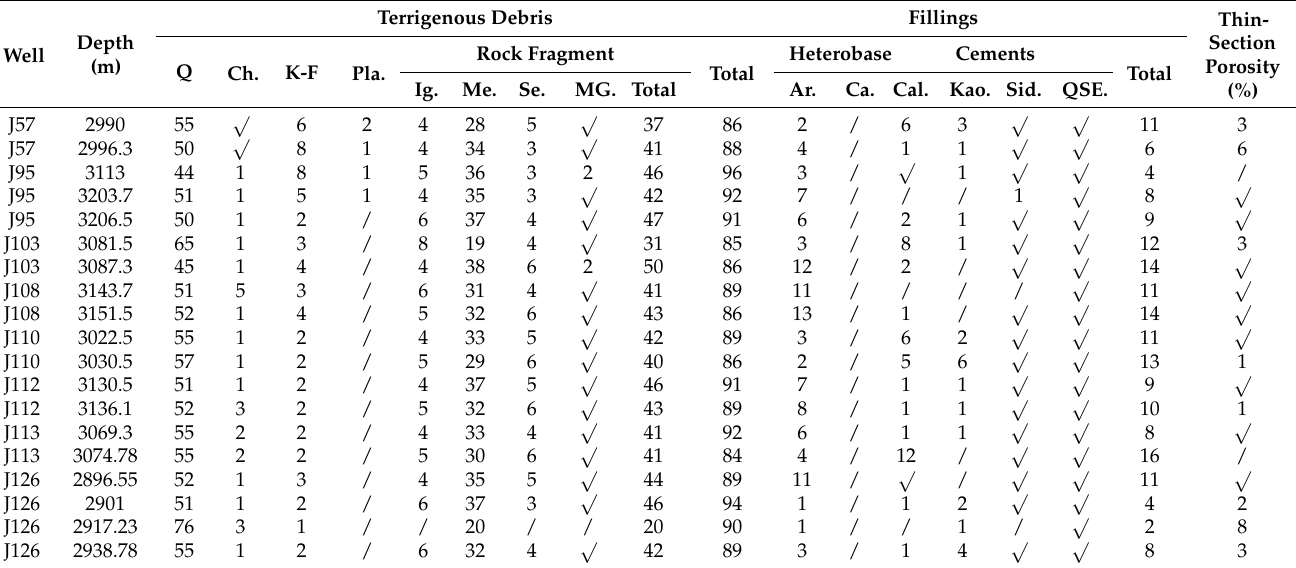
Table 1. Statistical for identification of casting thin section of sandstone of the Lower Shihezi Formation in the Duguijiahan